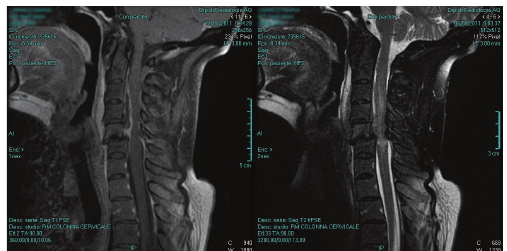
Figure 1: MRI Case 1: altered signal intensity with synovial effu- sion in interapophyseal joints C5-C6 and C4-C5, associated with extensive alteration of signal paravertebral soft tissues on the left paravertebral front and retropharyngeal from C1 to C7; there is also extensive alteration signal in correspondence with the epidural space anterior and lateral left from C3 to C6 and more evident in C4-C5 left side. Segmental stenosis of the spinal canal at C5- C6, with compression on the spinal cord and the abolition of the subarachnoid space perimedullary, is evident. The spinal cord has altered signal intensity level from C3 to C6. Framework compatible with the involvement of nature-infectious inflammatory type septic arthritis interapophyseal with paravertebral and epidural abscesses and